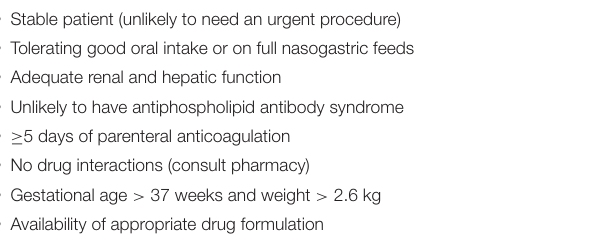
TABLE 2 | Considerations for initiating DOACs for treatment of pediatric